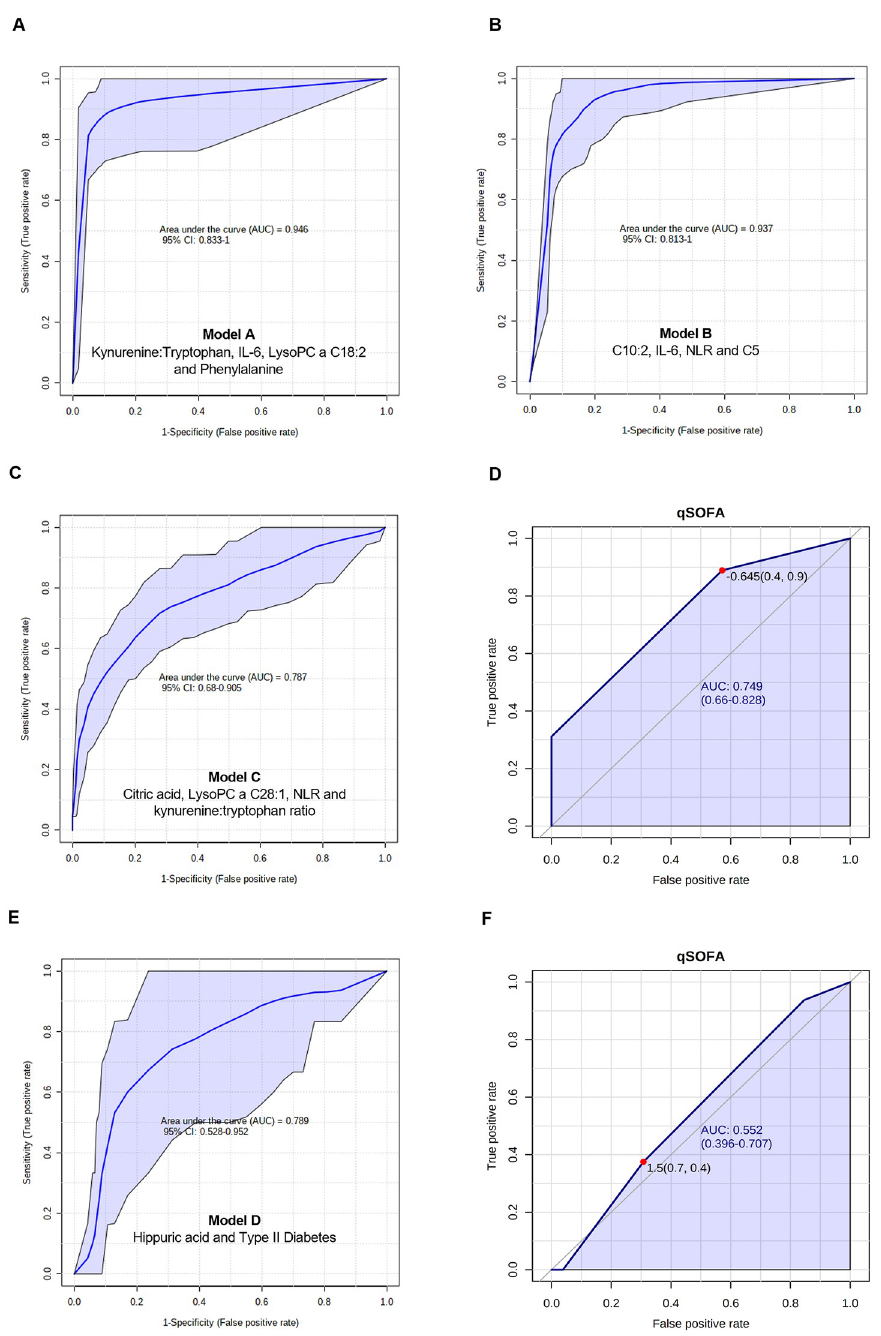
Fig 4. Multivariate and univariate models. (A) Multivariate ROC curve of model A: G1 vs. G4. (B) ROC curve of model B: G2 vs. G4. (C) ROC curve of the model C: G3 vs. G4. (D) Univariate ROC curve explaining the performance of qSOFA to predict sepsis in G3 and G4. (E) Multivariate ROC curve of model D: non-survivors vs. survivors from G4. (F) Univariate ROC curve explaining the performance of qSOFA to predict mortality in G4. Figures were made in MetaboAnalyst software v 4.0 (https://www.metaboanalyst.ca/).